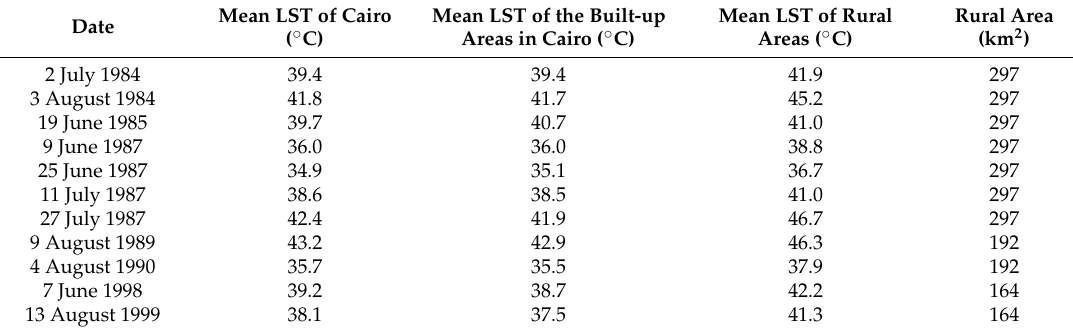
Table 9. The mean LSTs of the rural areas and their corresponding mean LST of